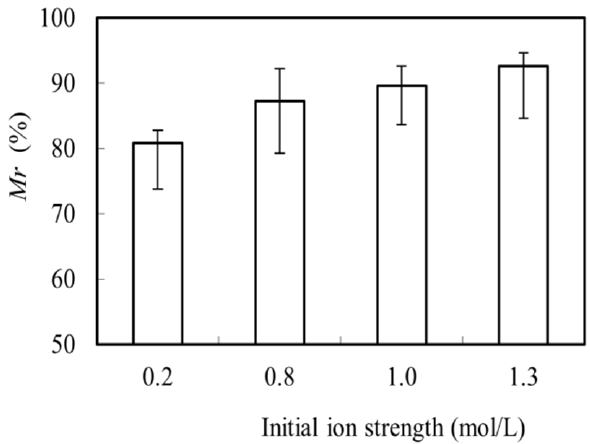
Figure 2. Effects of pH of the feeding solution on the migration efficiency ( Me ) of Mo(VI). In the trade effluent, there always existed various ions, which may affect the migration of Mo(VI). Thus the NaCl and KNO 3 were used to simulate and regulation ion strength of the simulated trade effluent. The effects of the initial ion strength in the feeding pool on the migration rate ( Mr ) of Mo(VI) was thus examined. As shown in Figure 3, the Mr of Mo(VI) increased when the initial ion strength changed from 0.2 mol/L to 1.3 mol/L, kept higher than 80%. Ionic strength has little impact on the MCR-OW system, which is more suitable for industrial application and lays a foundation for future industrial application [40].